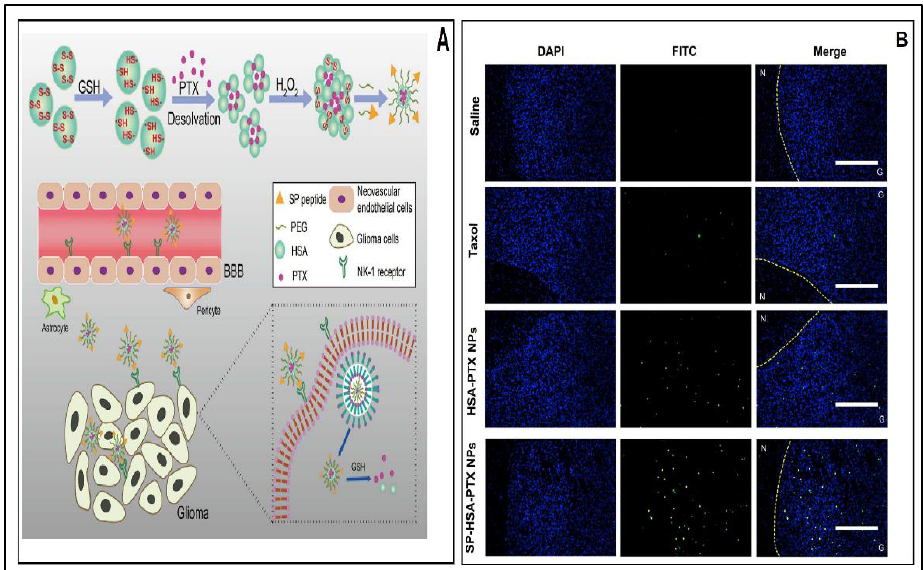
Figure 4. ( A ) Schematic representation of preparation and mechanism of action of albumin nanoparticles (NPs); ( B ) Fluorescent microscopic terminal deoxynucleotidyl transferase dUTP nick end labeling (TUNEL) assay images of in vivo anti-cancer efficacy of SP–HSA–PTX NPs (Green: TUNEL-stained apoptosis cells. Blue: 4′,6-diamidino-2-phenylindole (DAPI)-labeled nucleus, Yellow dashed lines: boundary between (N) normal brain and (G) glioma section). Reprinted with permission from [119], Elsevier, 2018.